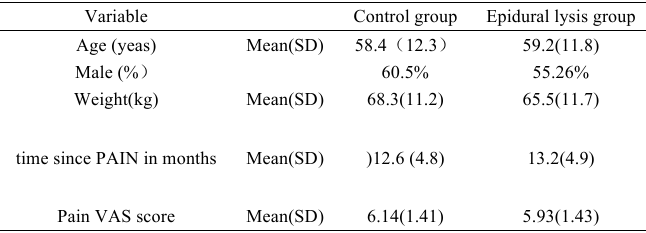
TABLE 1 - Demographic characteristics at inclusion (n=38).